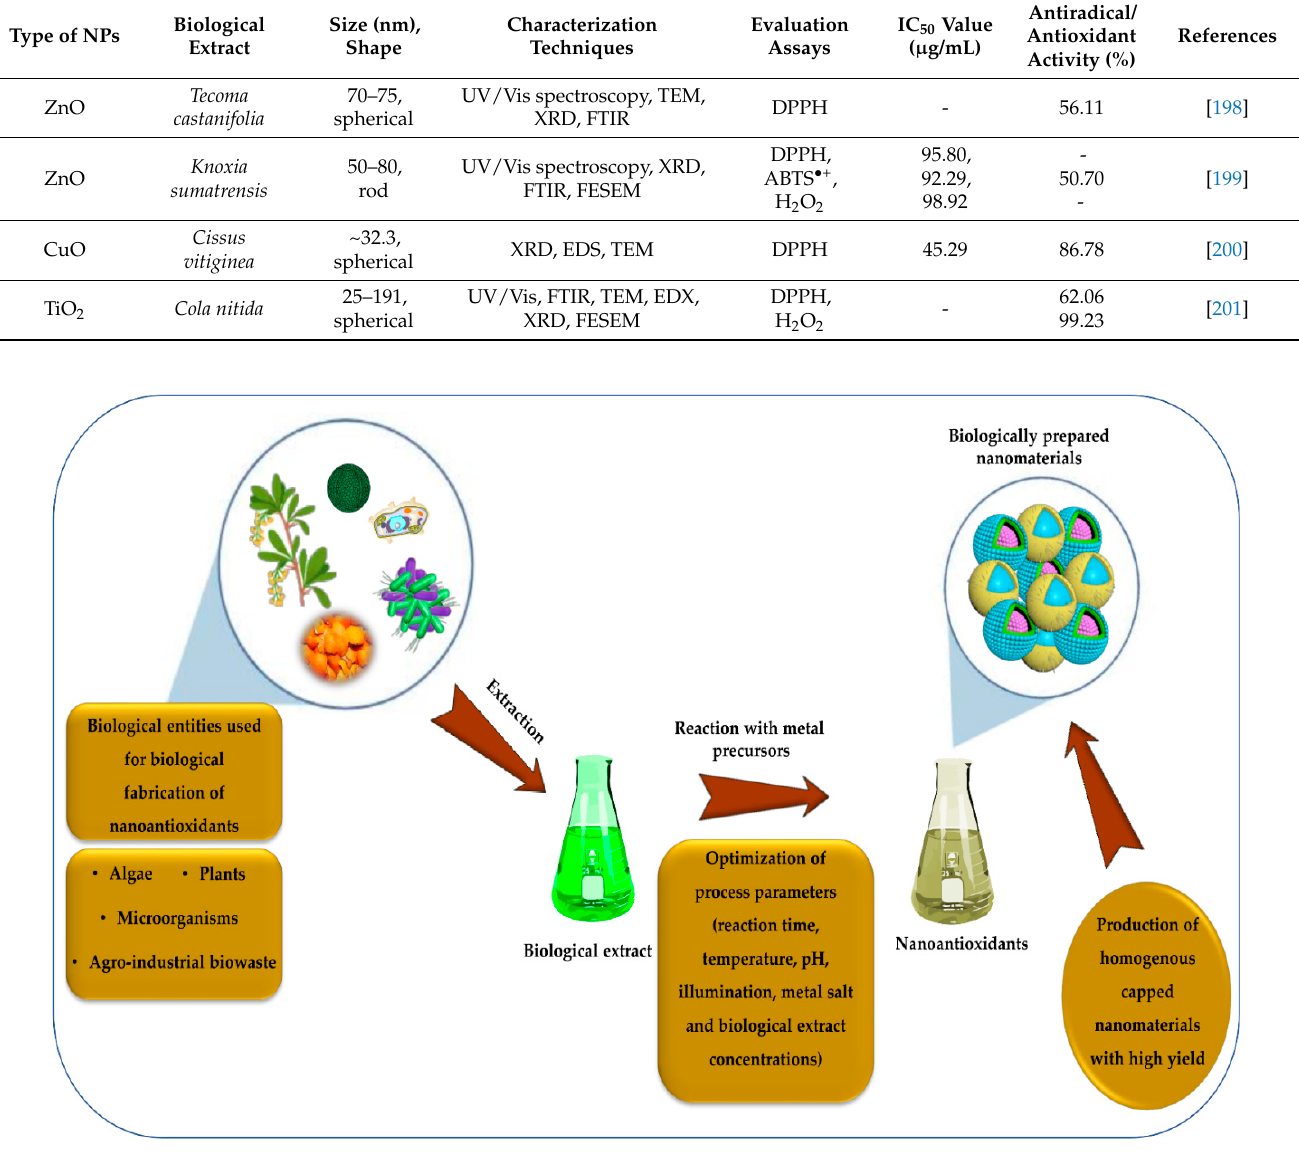
Figure 8. A schematic representation showing the biological fabrication of nanoantioxidants using different biological